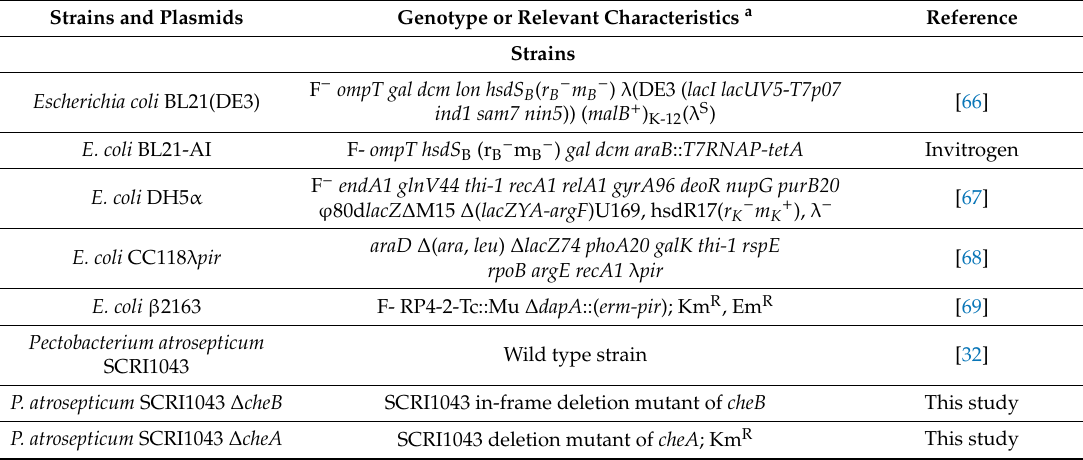
Table 1. Strains and plasmids used in this